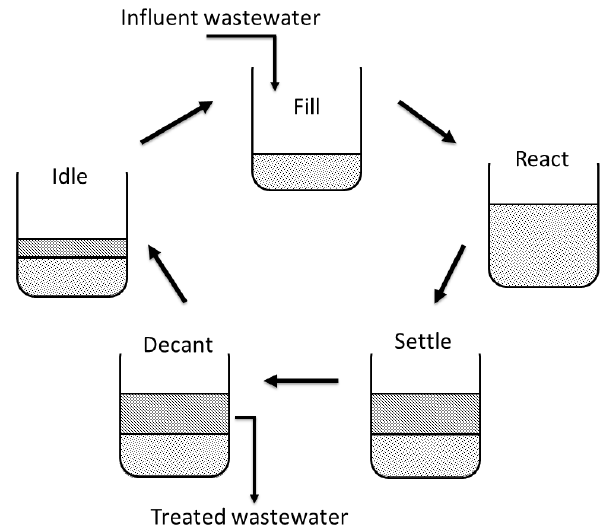
Figure 1. The sequencing batch reactor stages (adapted from Reference [41]).